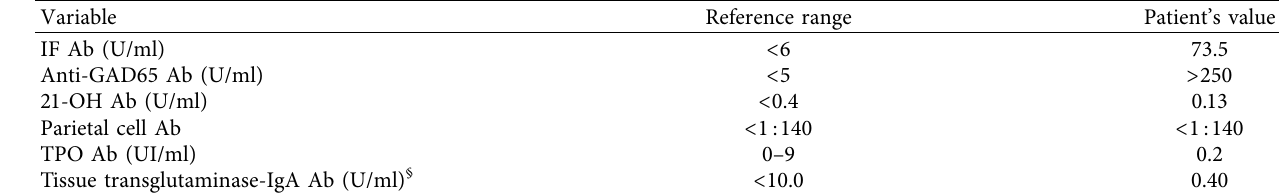
Table 3: Autoimmunity